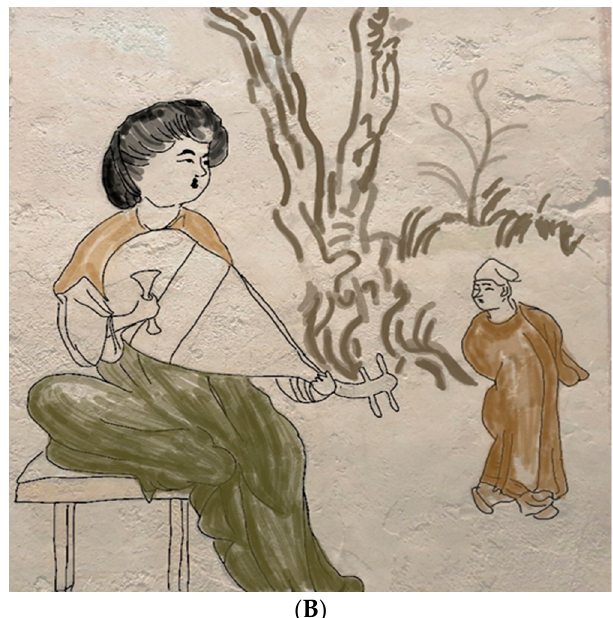
Figure 15. ( A ) Part of a mural painting of Kizil Grotto with a depiction of the Hu Pipa, chamber no. 38. The middle of fourth century to the end of fifth century, CE. Sketched by author. Picture source: Zhao (2003), p. 40. ( B ) Part of a mural painting of the tomb Nanliwang 南里王 village with a depiction of Hu Pipa. The Tang Dynasty. Sketched by author. Picture source: Shaanxi History Museum.